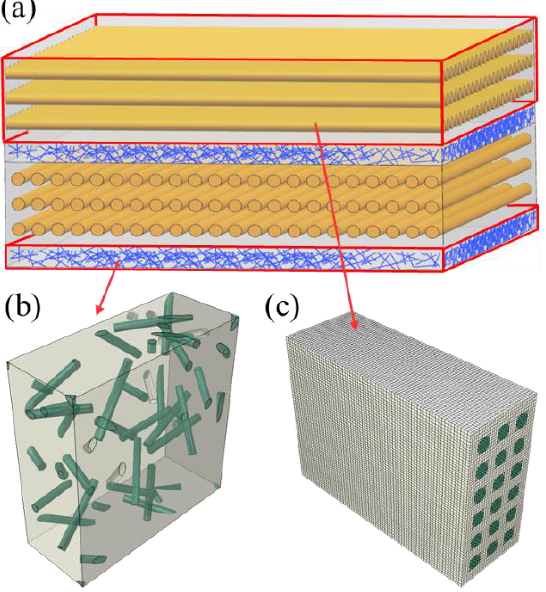
Figure 5. Geometric model of each component. ( a ) the un-needling region ( b ) short-cut fibers ply ( c ) weftless ply.